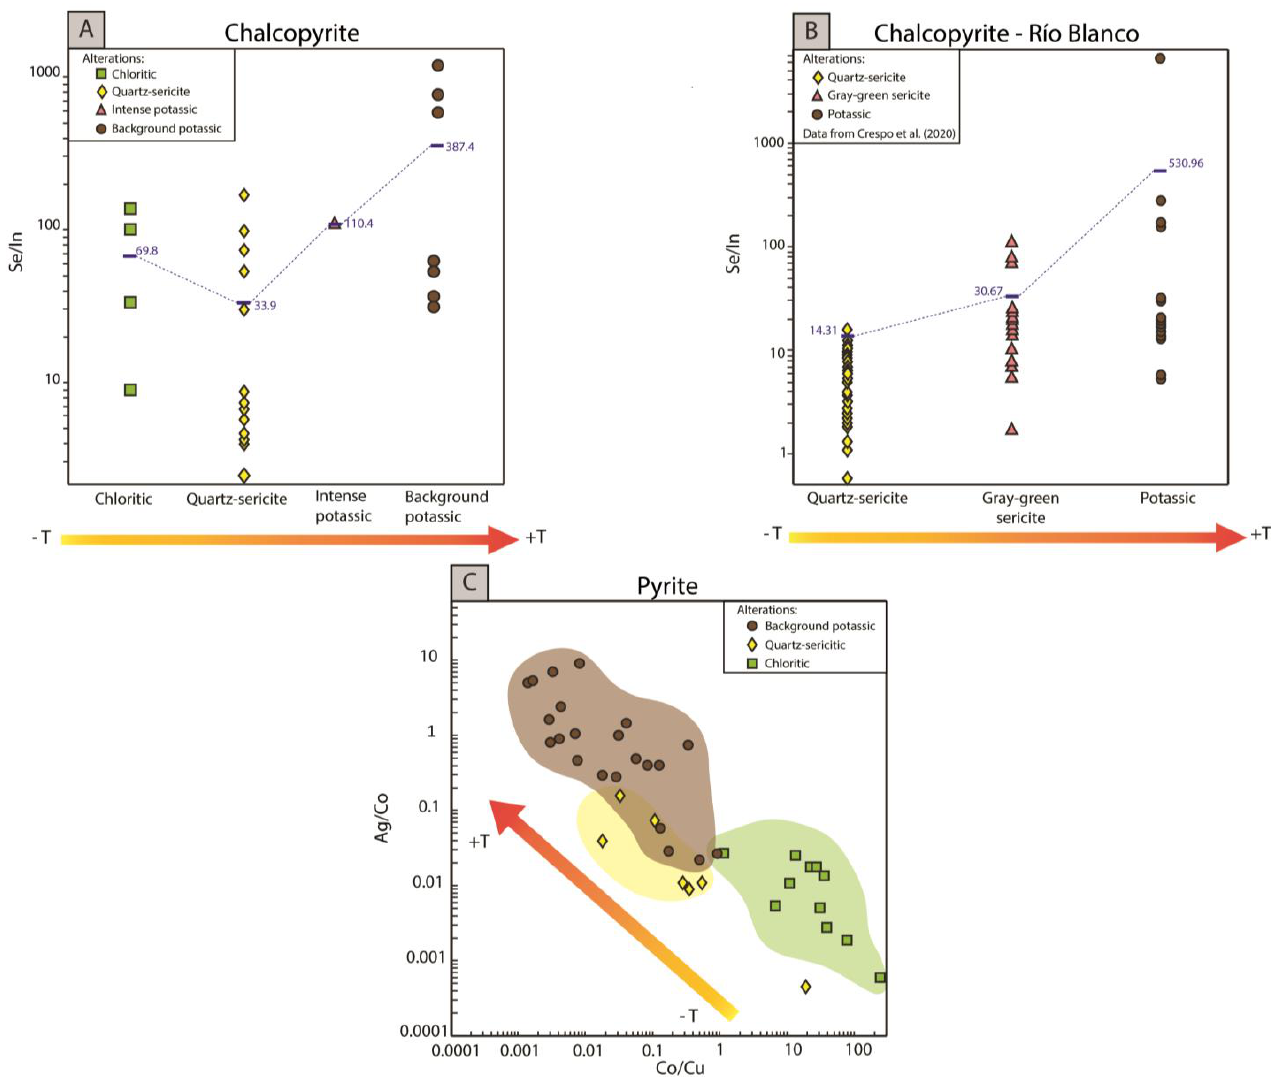
Figure 10. ( A ) Se/In ratios of chalcopyrite from the Chuquicamata Underground deposit as a function of alteration. The average of each element ratio for each alteration is observed next to the horizontal line. ( B ) Se/In ratios of chalcopyrite from the Río Blanco porphyry deposit (data taken from [26]). As in ( A ), data was plotted as a function of alteration. ( C ) Ag/Co vs. Co/Cu scatterplot for pyrite from Chuquicamata Underground deposit. Elemental ratios are plotted in on a logarithmic scale (only LA-ICP-MS data included).